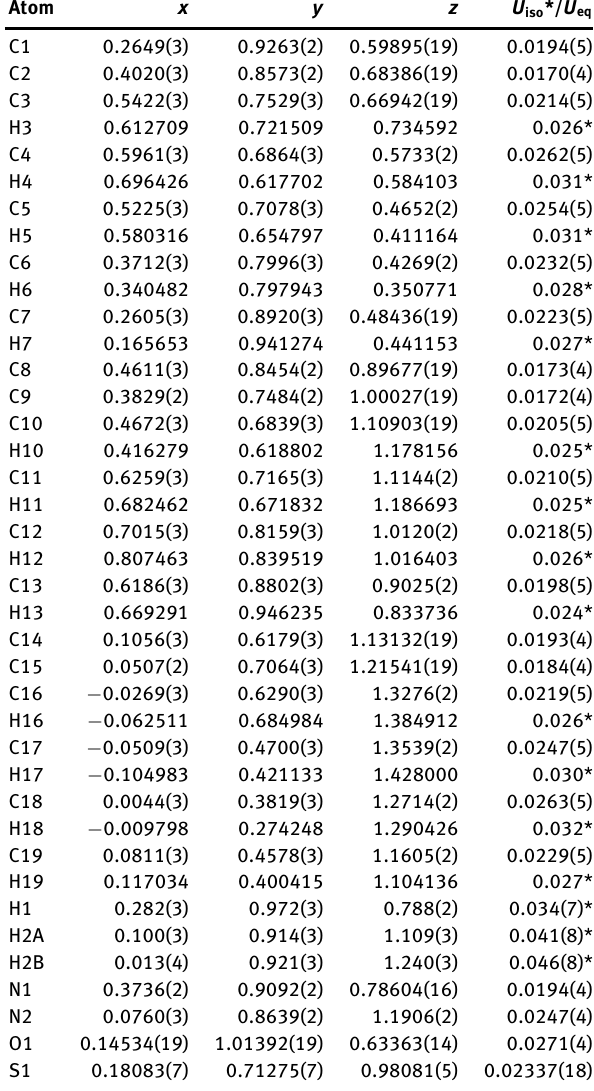
Table 2: Fractional atomic coordinates and isotropic or equivalent isotropic displacement parameters (Å 2